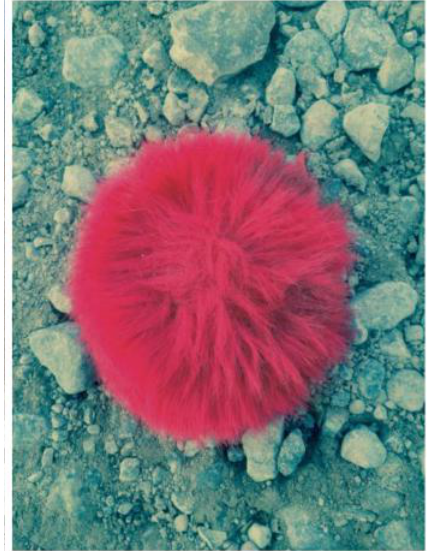
Figure 1. Pompom sea anemone on Car Park Beach.